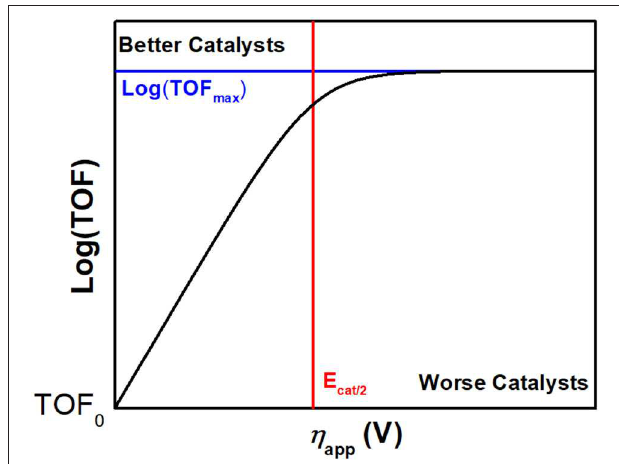
FIGURE 3 | Example of a catalytic Tafel plot of a generic molecular species with regions where better and worse catalysts are located explicitly labeled, along with the position of important benchmarking parameters.